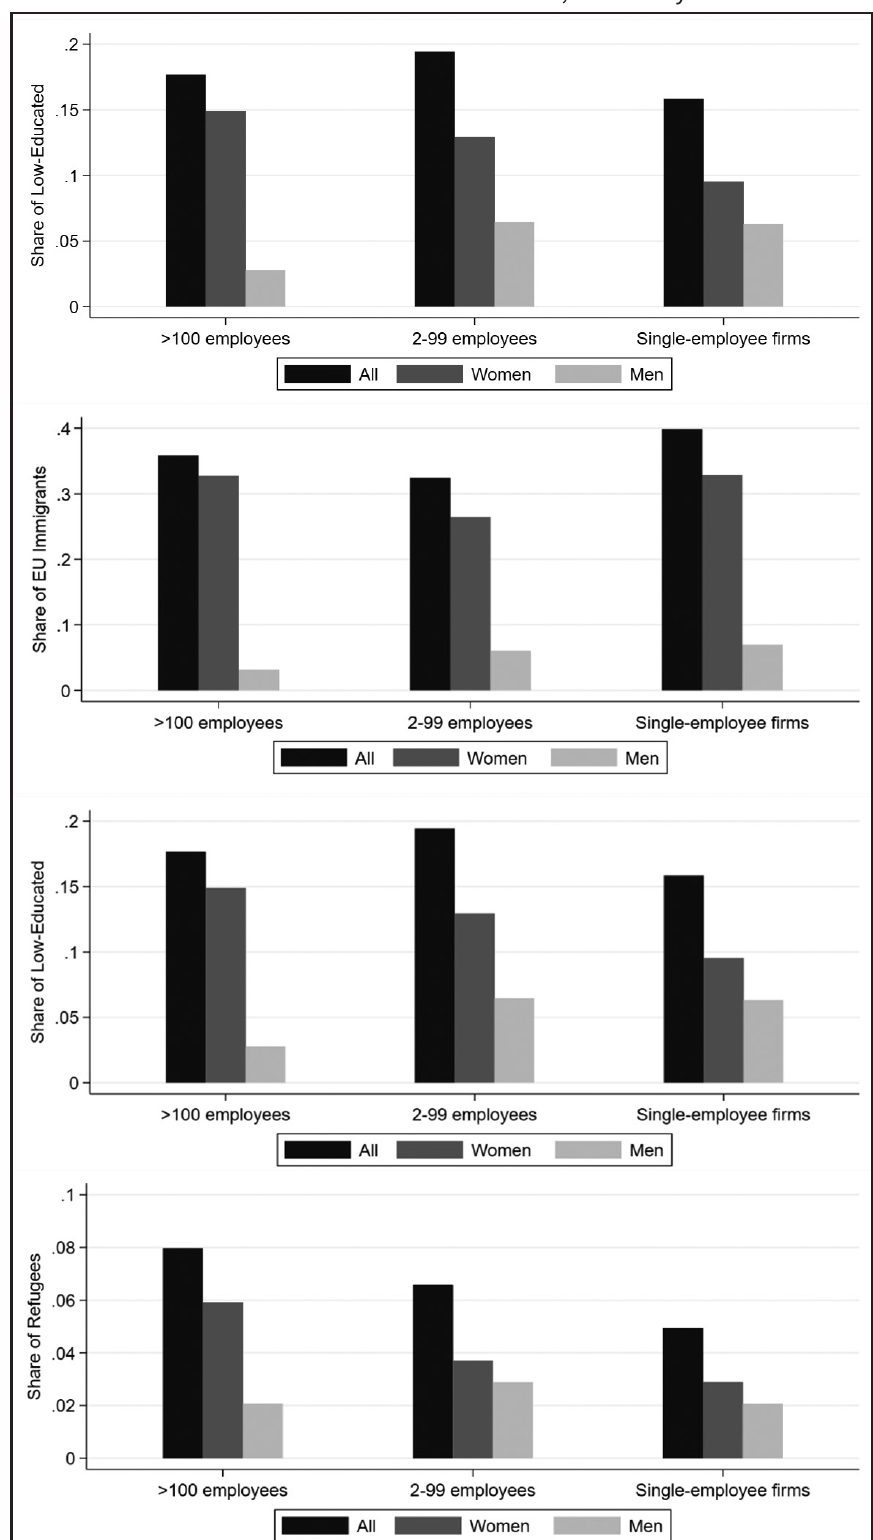
Figure W14 Shares of EU immigrants, people with low education, and refugee immigrants in subsidized domestic service firms, divided by firm